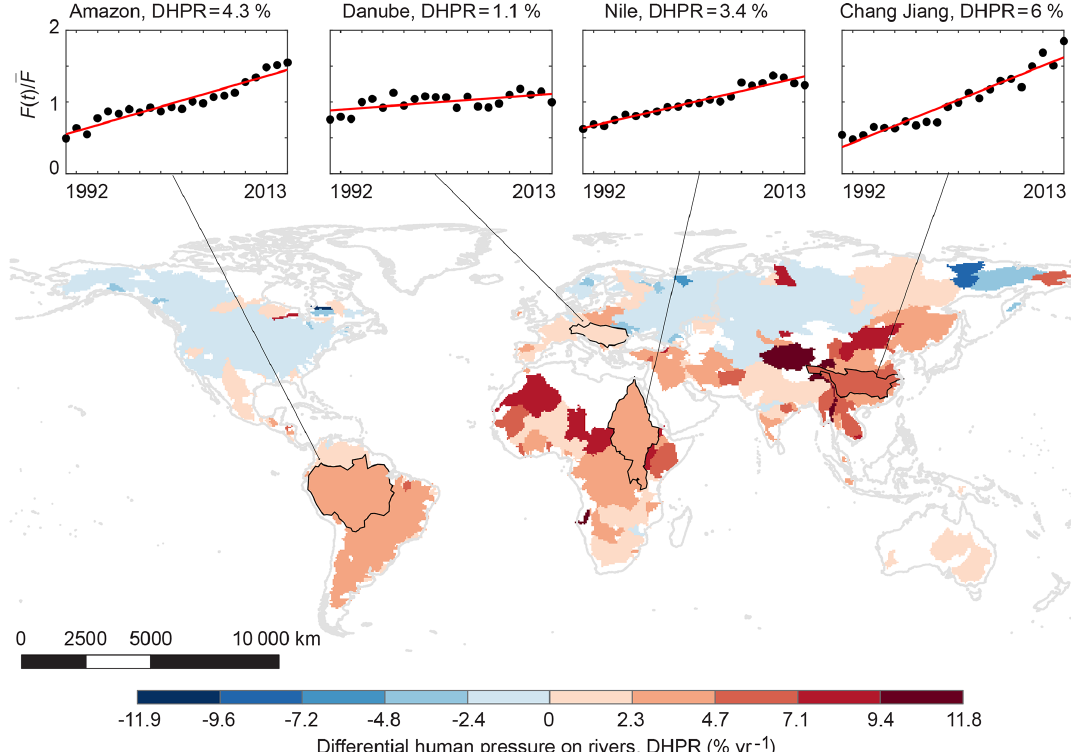
Figure 3. Global distribution of the Differential Human Pressure on Rivers index, DHPR. The map shows the relative change rate (i.e., per- year percentage increment or decrement) of normalized human pressure values, defined as the ratio between annual and long-term average standardized human pressure on river systems, F(t)/F . Colors differentiate basins (2195 in total) according to levels of DHPR. Insets show the historic evolution of normalized human pressure on river systems for Amazon, Danube, Nile and Chang Jiang river basins, where data are depicted as black dots and the red lines represent Eq. (5).